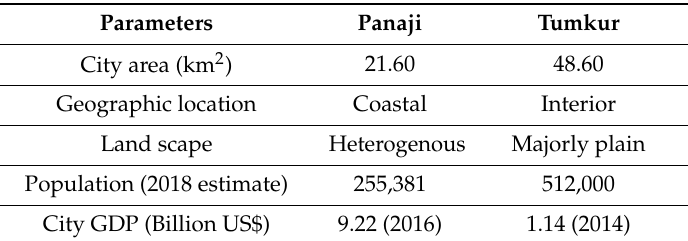
Table 1. Details of di ff erent demographic, meteorological, and other parameters from Panaji and Tumkur cities proposed to be developed as smart cities